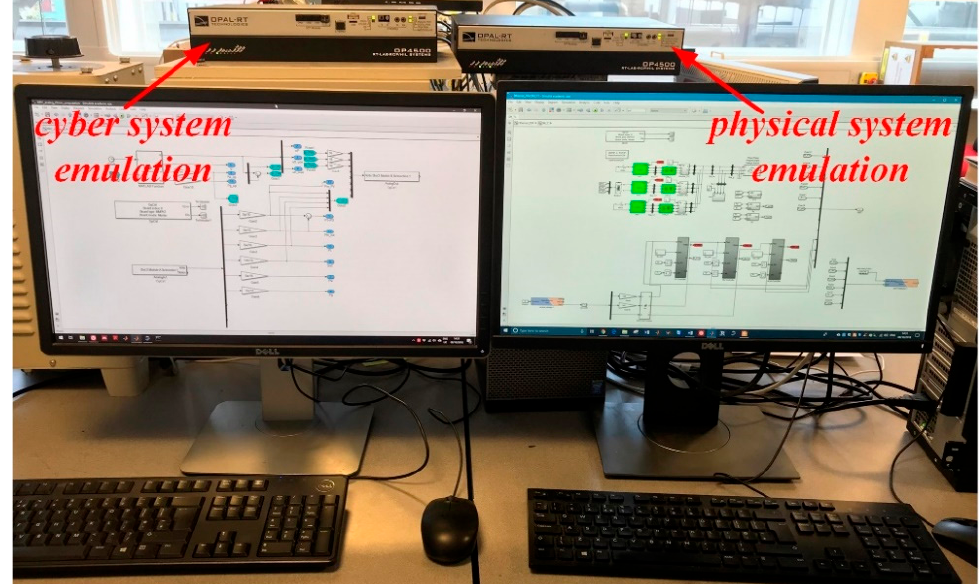
Figure 10. Cyber–physical testbed (co-simulation framework).